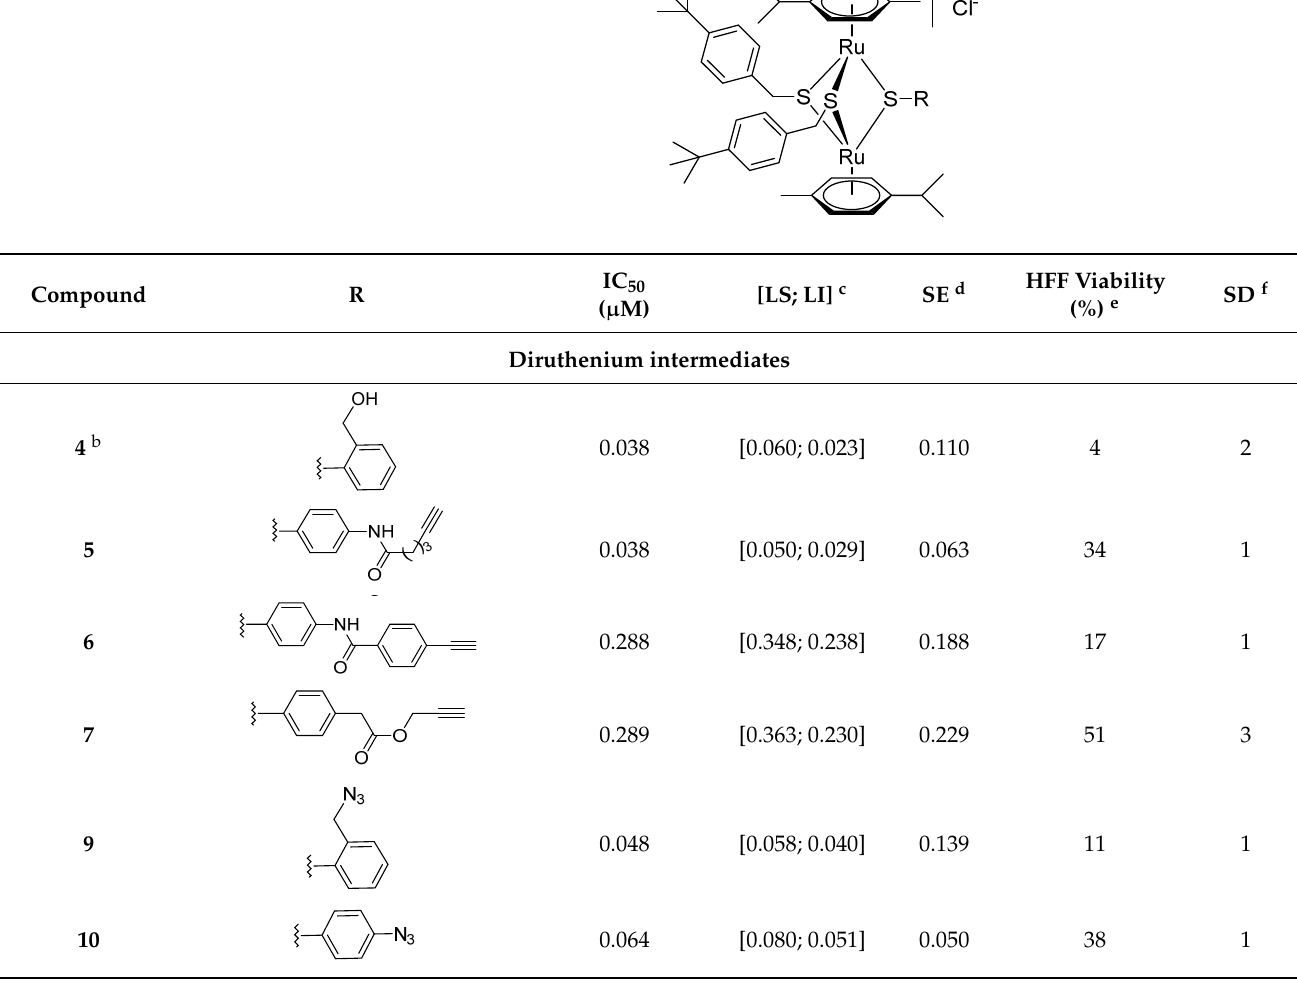
Table 2. Half maximal inhibitory concentration (IC 50 ) values ( µ M) on T. gondii β -gal for the 20 selected compounds and their effect at 2.5 µ M on HFF viability.